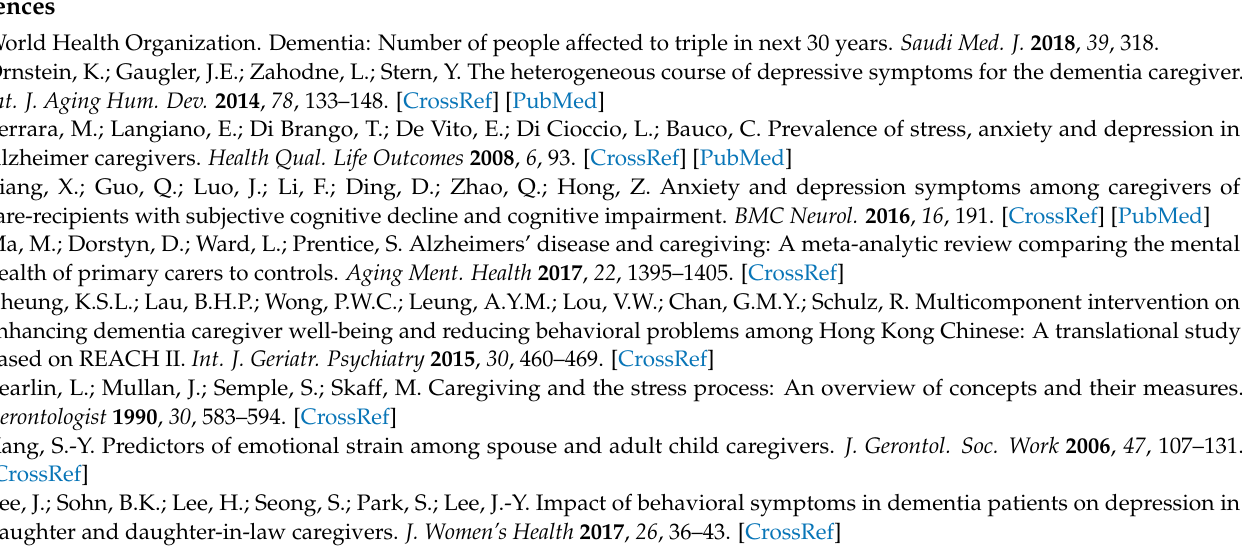
Figure A1. Layout of the e-painting app and the selected paintings. Note: The layout of the e-painting app presented five core functions in the app (1: picture sharing; 2: painting; 3: chatroom; 4: announce- ment; 5: self-assessment). The non-English language on the second painting means “appreciating cherry blossoms in